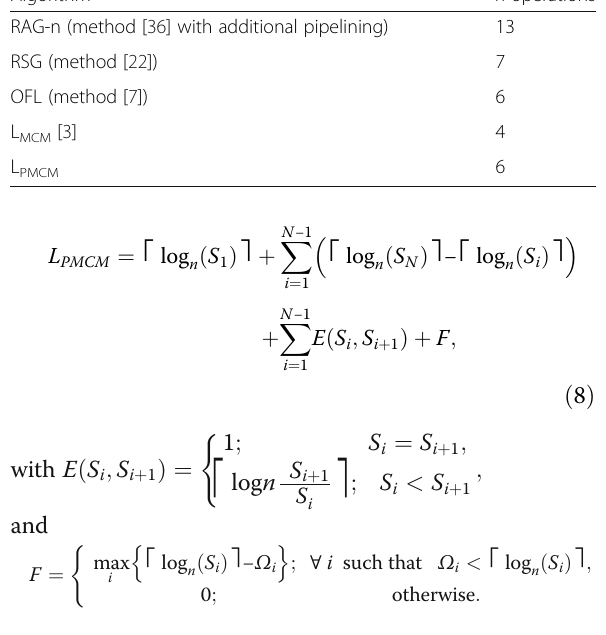
Table 5 Resulting R -operations for Example 3 using n = 2 input adders Algorithm